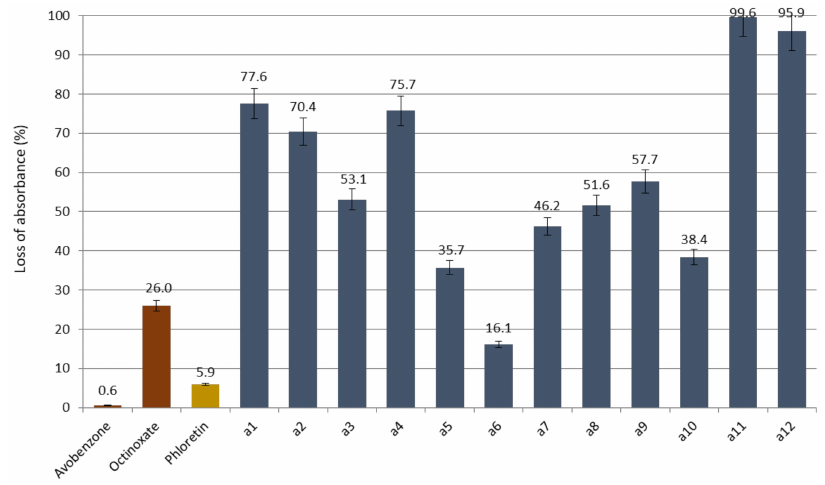
Figure 4. Loss of absorbance (in %) for chalcone series, phloretin and references avobenzone and octinoxate.